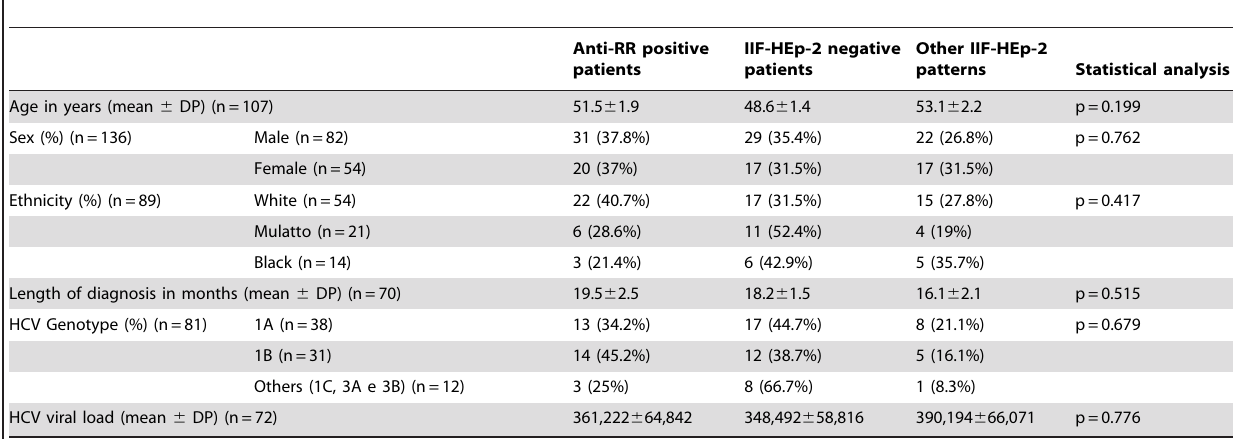
Table 2. Demographic data, time of HCV diagnosis, HCV genotype, and HCV viral load in HCV patients according to the presence of anti-RR and other IIF-HEp-2 patterns*